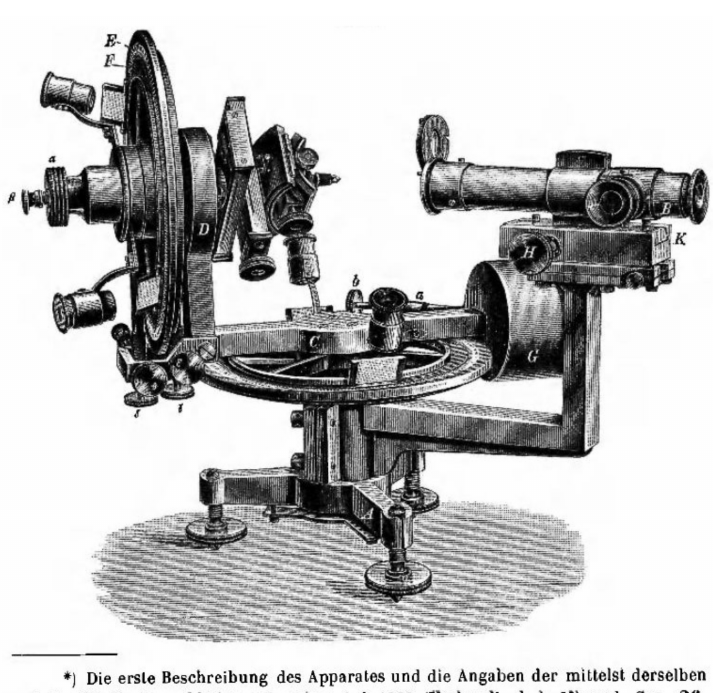
Figure 7. Universal (Theodolite) Method in Mineralogy and Petrography. In the footnote Fedorov mentions that the first version of this equipment has been published already in 1889 and that the mechanic Petermann recently performed a second sample, which has been improved several times. (E. v. Fedorov [32], p. 603, Figure